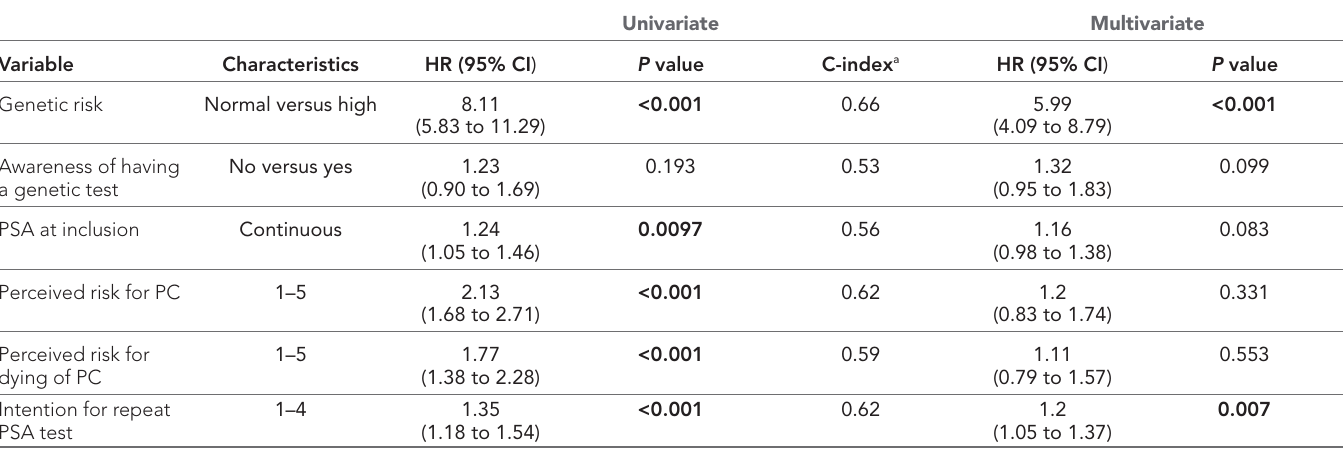
Table 3 Cox regression analysis for repeat PSA test ( N = 555, 160 with repeat PSA test). Uni- and multi- variate Cox regression, using genetic risk score, awareness of having a genetic test, PSA level at inclusion, perceived risk of PC, perceived risk of dying from PC, and intention for a repeat PSA were investigated as potential explanatory variables for actually having a repeat PSA test within 2